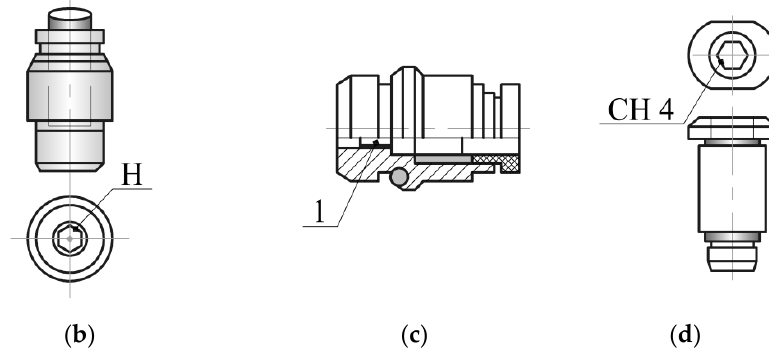
Figure 9. Designs of pneumatic collet fittings: ( a ) Camozzi Automation [93]; ( b ) SMC [95]; ( c ) Festo [94]; and ( d ) Metal Work [92].